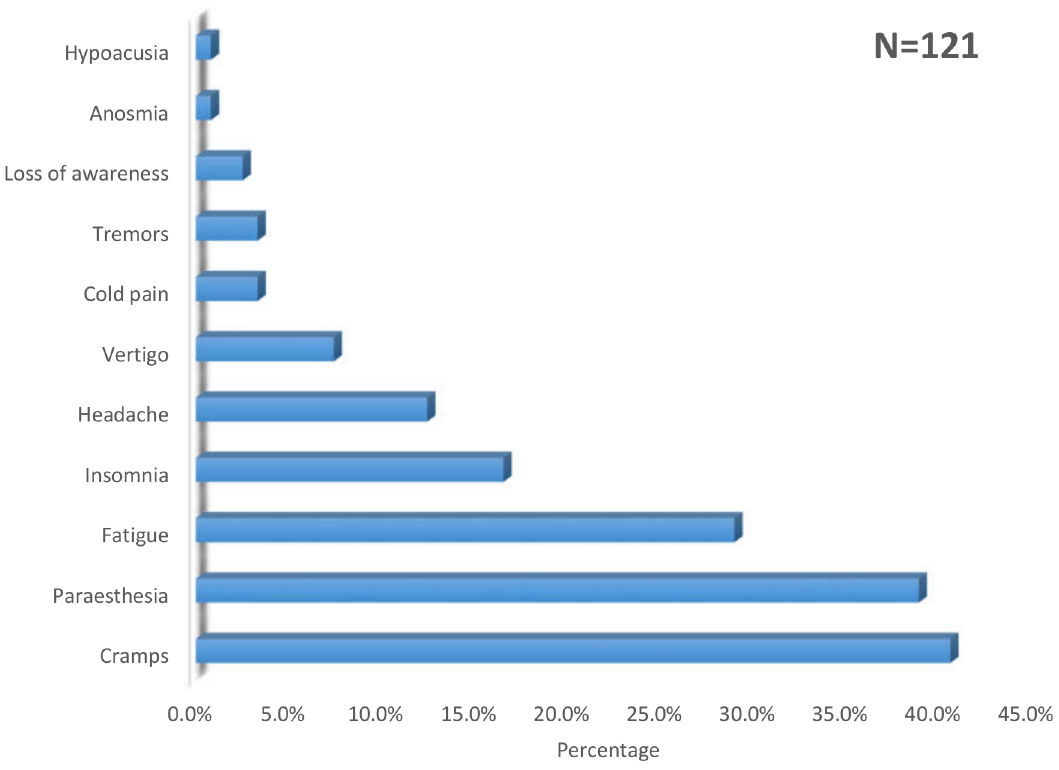
Fig 2. Neurological symptoms reported by chronic hepatitis C patients.